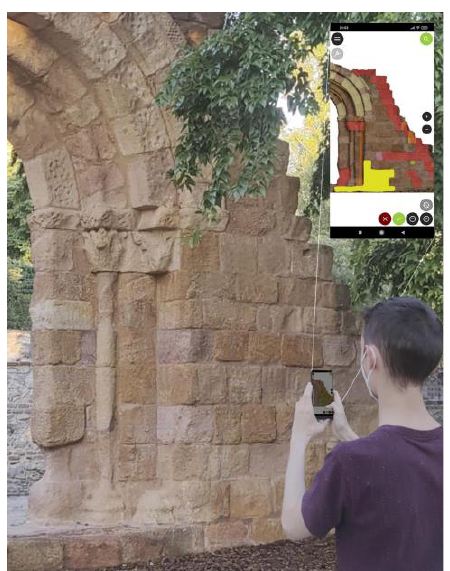
Figure 8. Moment on which the damage is mapped by using the QField app.